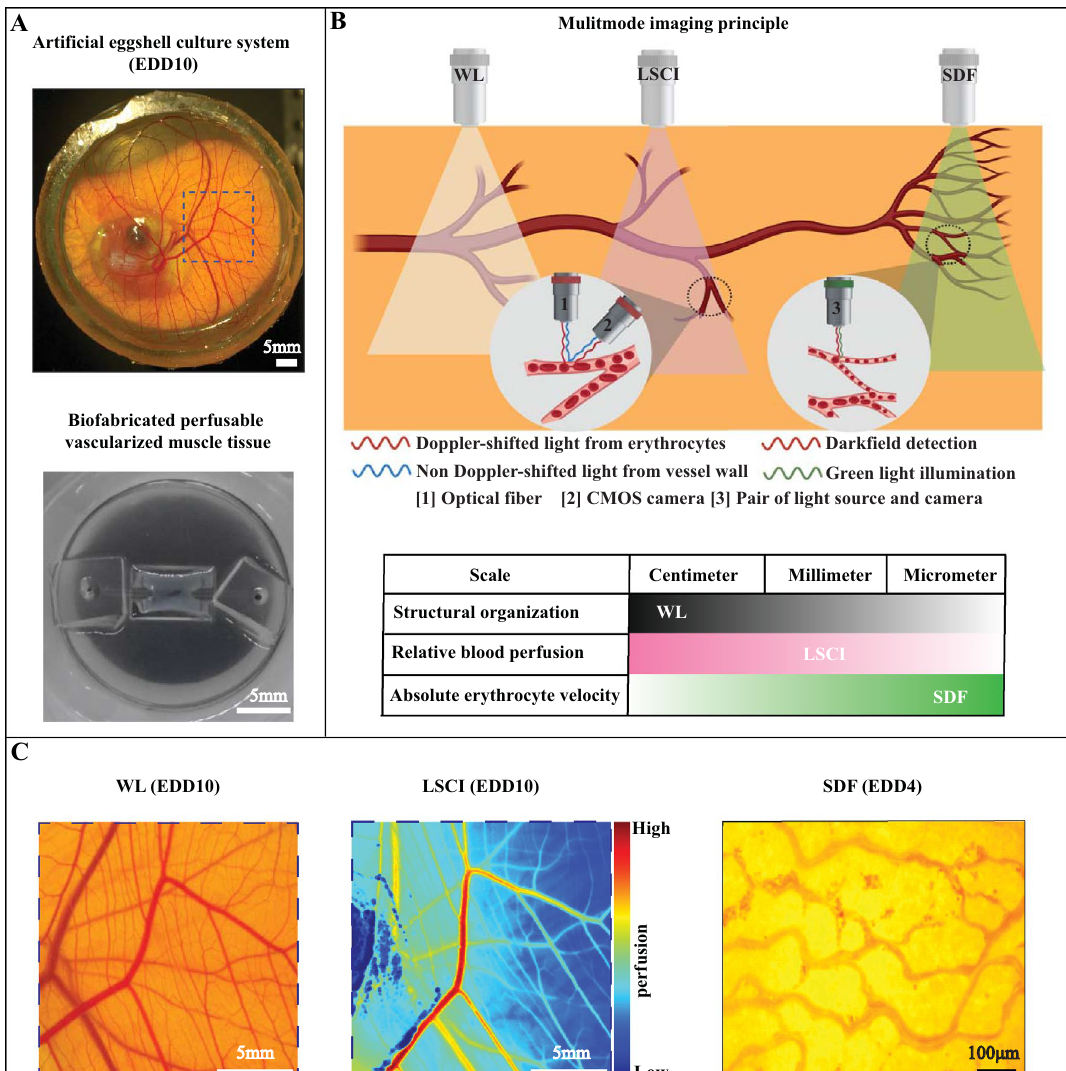
Figure 1. Multimode imaging for probing vascular organization and associated flow dynamics. Panel ( A ) shows the artificial eggshell culture system with fully developed chick embryo of embryo development stage day 10 exhibiting multiscale vasculature of varying complexity, as well as a biofabricated vascularized tissue analogue. Both systems are compatible with WL, LSCI and SDF imaging methods and represent the proof-of- concept application towards engineering functional tissue constructs. Panel ( B ) shows the schematics explaining the principle of multiple imaging methods used in this study, with highlighted potential and limitations of the above-mentioned imaging methods. Panel ( C ) represents the examples of output results obtained from multiple imaging methods. Abbreviations: WL—white light (color) imaging; LSCI—laser speckle contrast imaging and SDF—side-stream dark field microscopy; EDD—embryo development day. Panel ( B ) schematic figure was created using